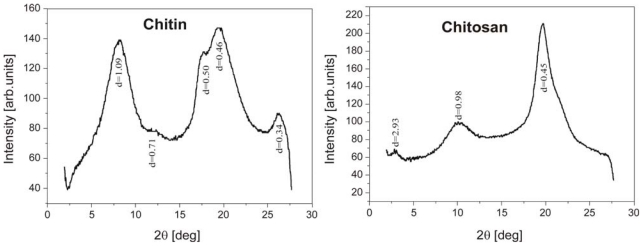
X-ray diffraction spectra of chitin and chitosan fibers. Reprinted from Carbohydrate Polymers 56, 2004, Muzzarelli, C., Francescangeli, O., Tosi, G., Muzzarelli, R.A.A., Susceptibility of dibutyryl chitin and regenerated chitin fibers to deacetylation and depolymerization by lipases, 137–146, Copyright (2010), with permission from Elsevier [56].